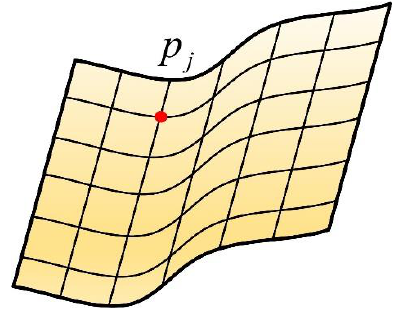
Figure 7. Surface to be solved.